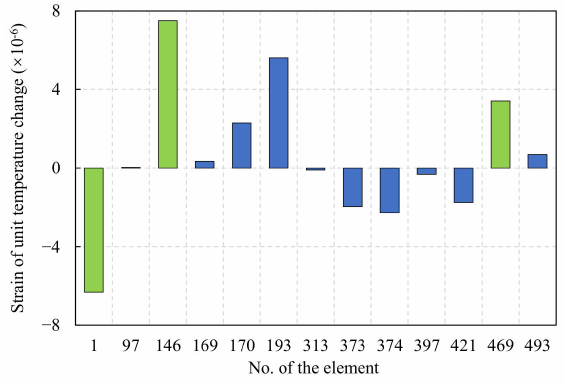
Figure 9. Strain under unit temperature increase of important